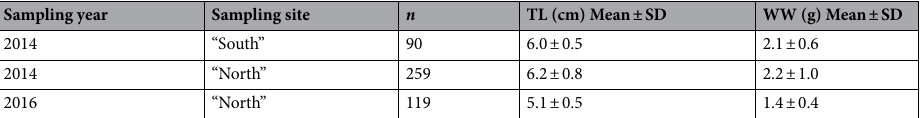
Table 3. Number of young-of-the-year (YOY) perch ( Perca fluviatilis ) sampled from Lake Müggelsee (Berlin, Germany) with their respective sampling year and site. Total length (TL) and wet weight (WW) are given as means ±